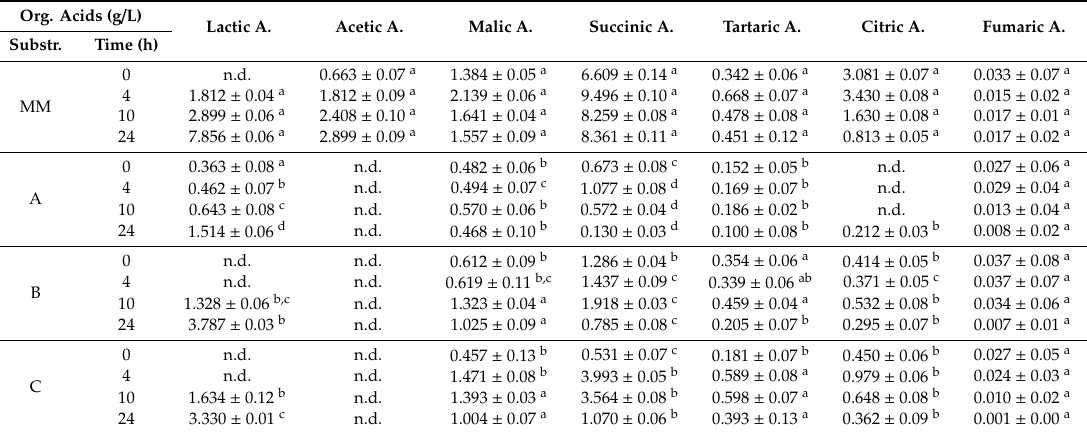
Table 2. Organic acid production through fermentation with